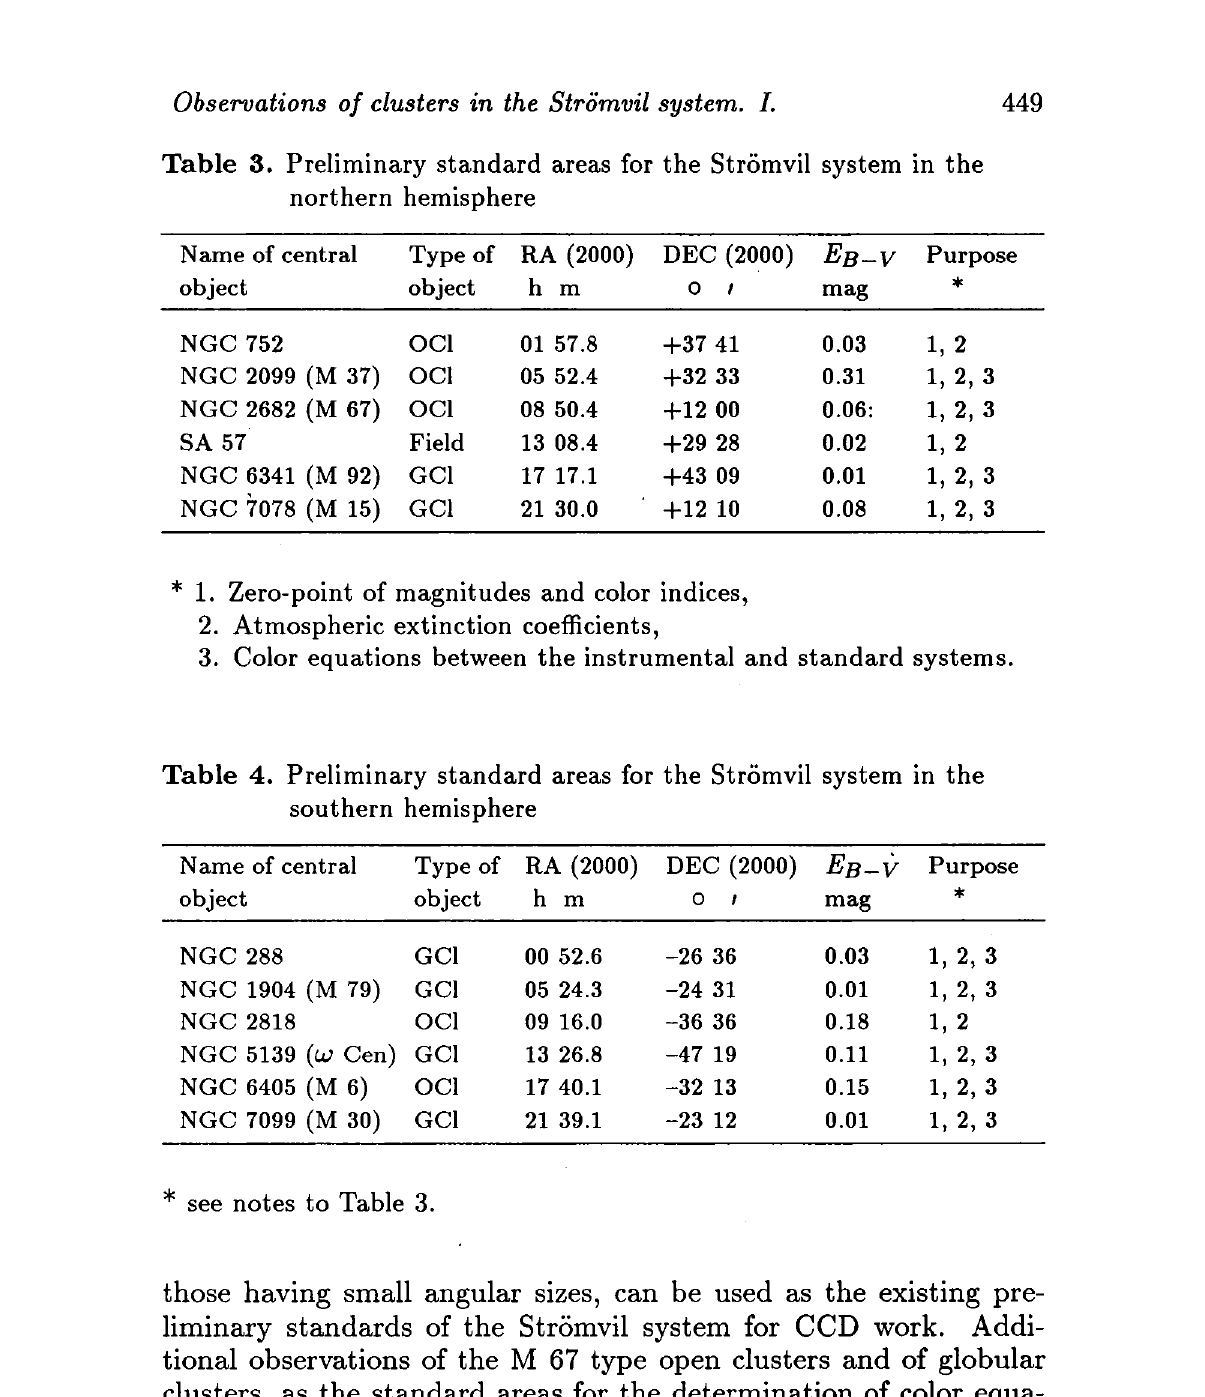
Table 3. Preliminary standard areas for the Strömvil system in the northern hemisphere